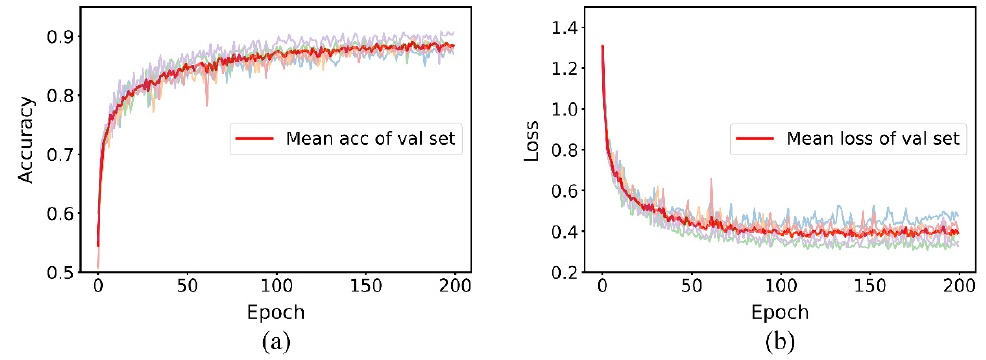
Figure 9. Five test results of baseline. ( a ) The accuracy curve and ( b ) the loss curve.